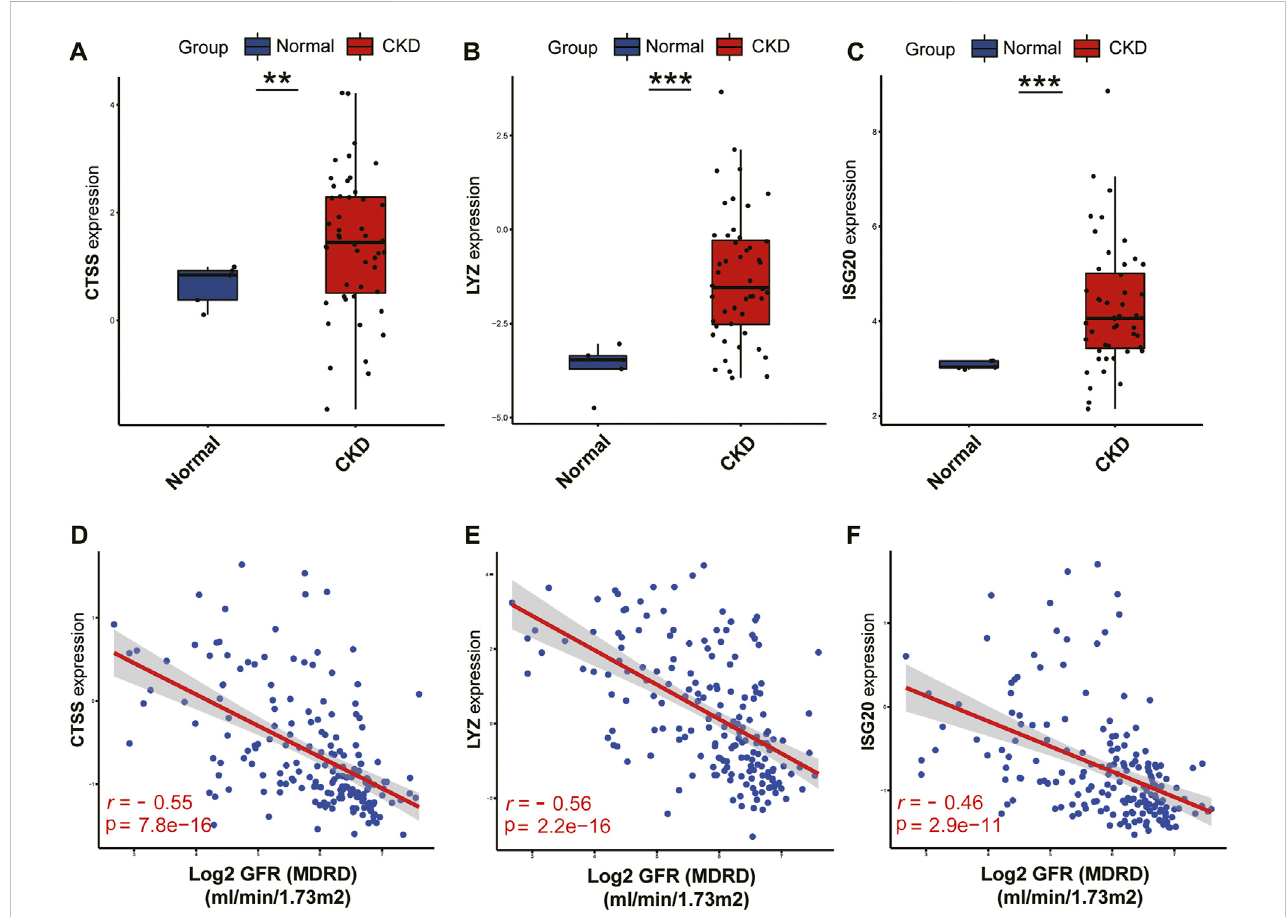
FIGURE 13 Validation ofthethree identi fi edbiomarkersand clinicality analysis. (A – C) Expression patternsofidenti fi edbiomarkers CTSS (A) , LYZ (B) ,ISG20 (C) . (D – F) Correlation between the expression of biomarkers CTSS (D) , LYZ (E) , ISG20 (F) and renal function indicators. *** p < 0.001; ** p < 0.01; and * p < 0.05.